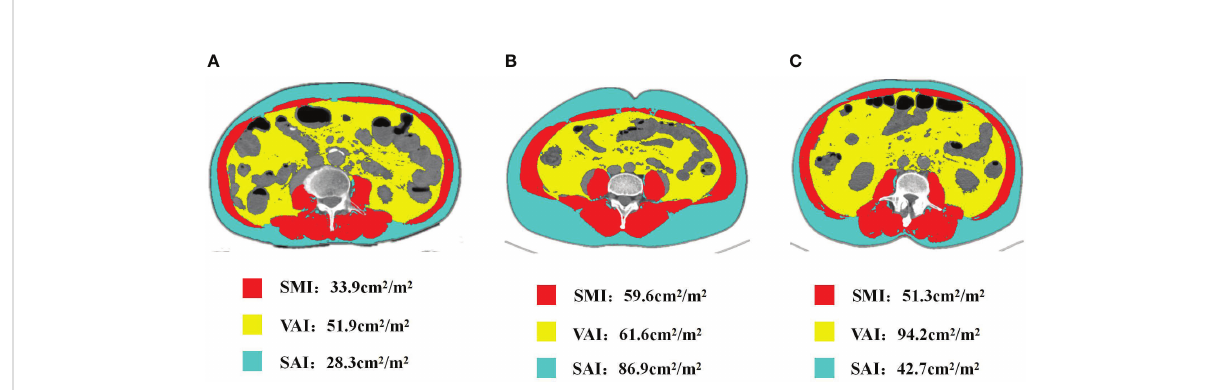
FIGURE 2 The portal phase computed tomography image of the L3 level was used to measure the body composition. Red: SM, Skeletal muscle;Yellow: VAT, Visceral adipose tissue;Blue:SAT, Subcutaneous adipose tissue; (A) L-SMI, Low skeletal muscle index; (B) H-SAI, High subcutaneous adipose index; (C) H-VAI,High visceral adipose